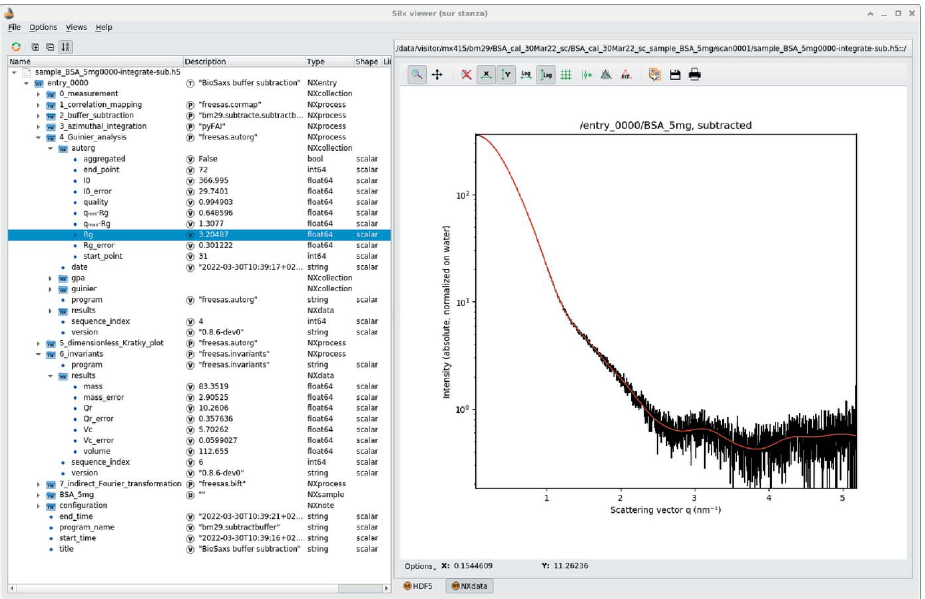
Figure 7 Default visualization of the HDF5 file produced by the sample changer pipeline with the silx viewer. The superimposed red curve corresponds to the BIFT modelled